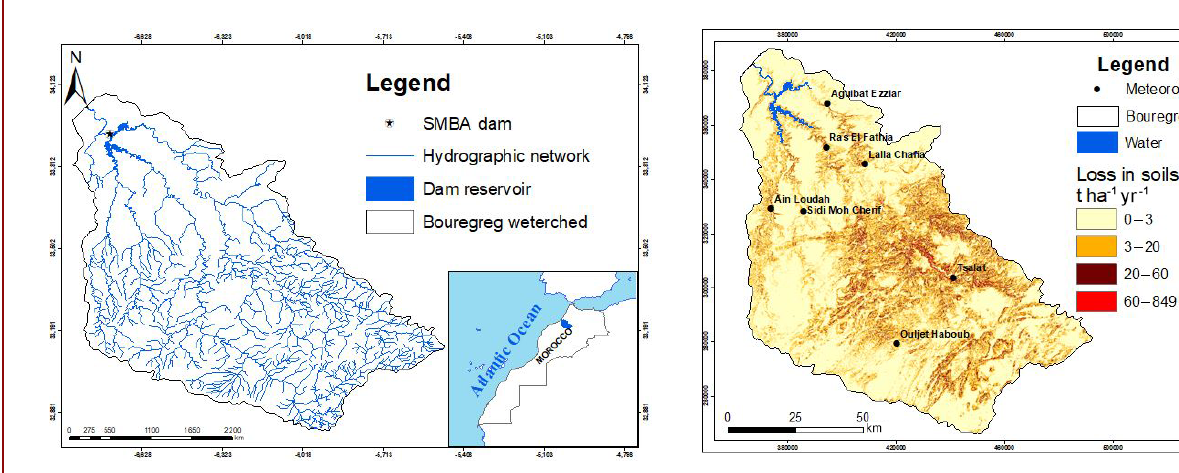
Figure 1. Location of the Bouregreg Watershed. Figure 2. Spatial distribution map of soil losses in the Bouregreg watershed.